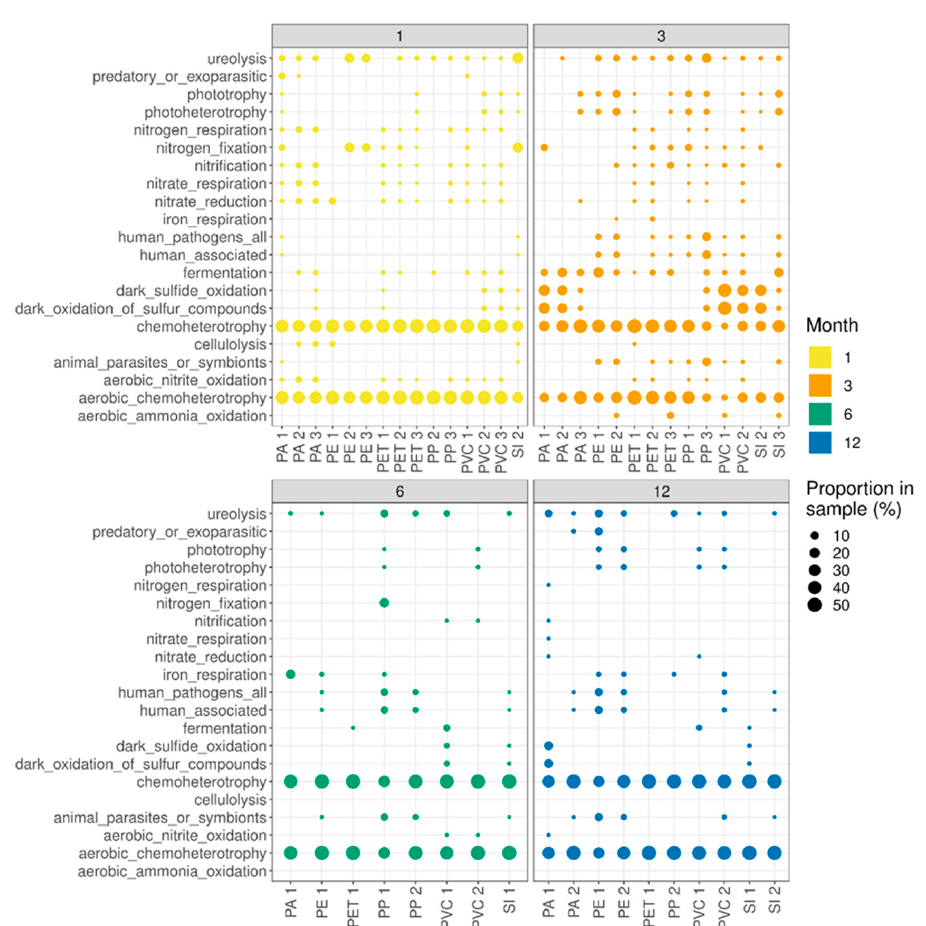
Figure 3. Inferred functional diversity based on FAPROTAX. PA: polyamide; PE: polyethylene; PET: polyethylene terephthalate; PP: polypropylene; PVC: polyvinyl chloride; SI: silica (control).